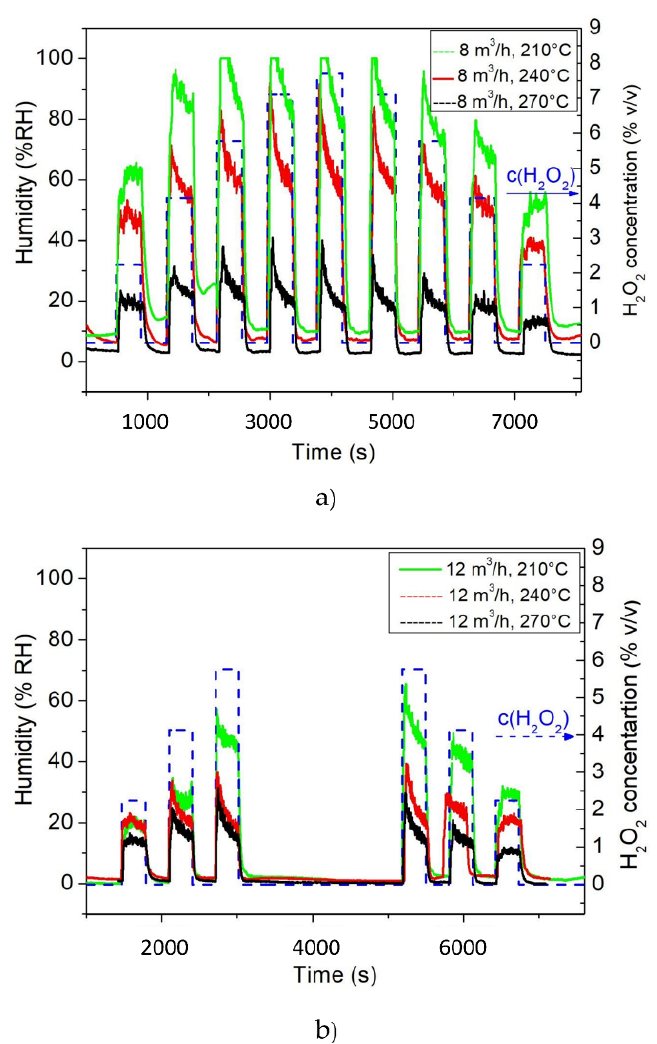
Figure 4. Assessing the relative humidity changes under the varying gas flow rates of 8 m 3 /h ( a ) and 12 m 3 /h ( b ) at temperatures of 210, 240 and 270 °C with H 2 O 2 concentrations of between 0 and 7.7% v/v .